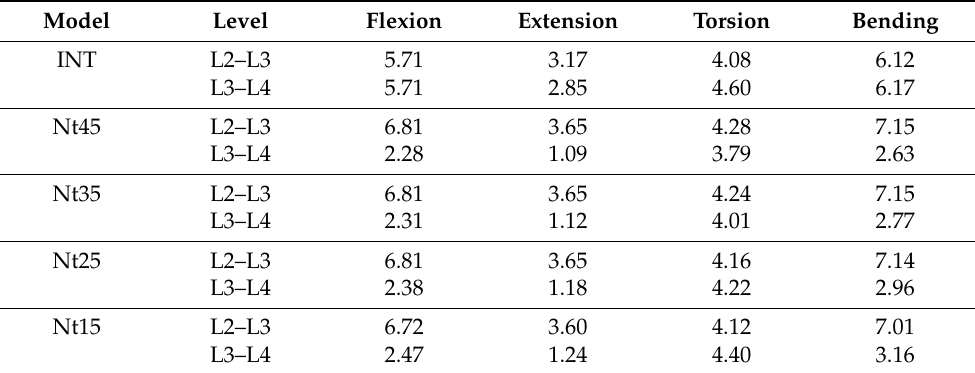
Table 4. Comparison of intervertebral range of motion (degree) in finite element